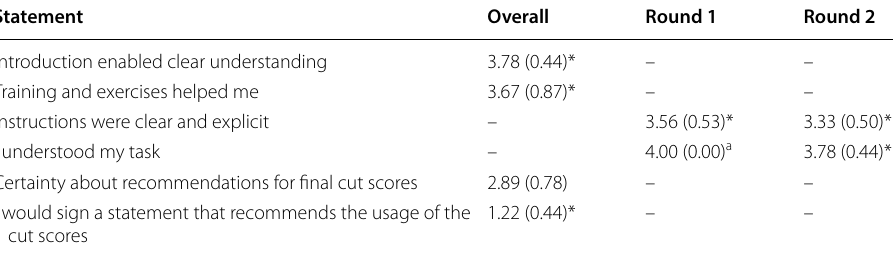
Table 3 Experts’ evaluation of the clarity and explicitness of the standard-setting process (Mean and standard